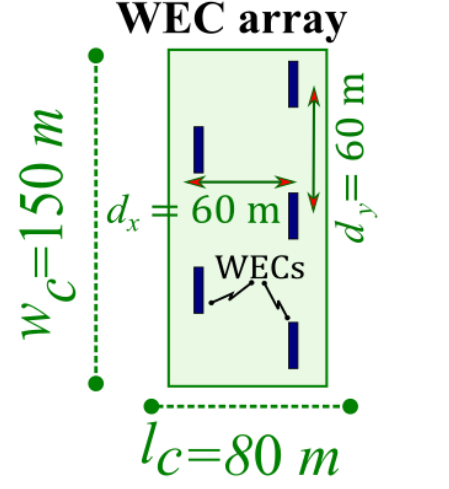
Figure 5. 5-WEC Array; top